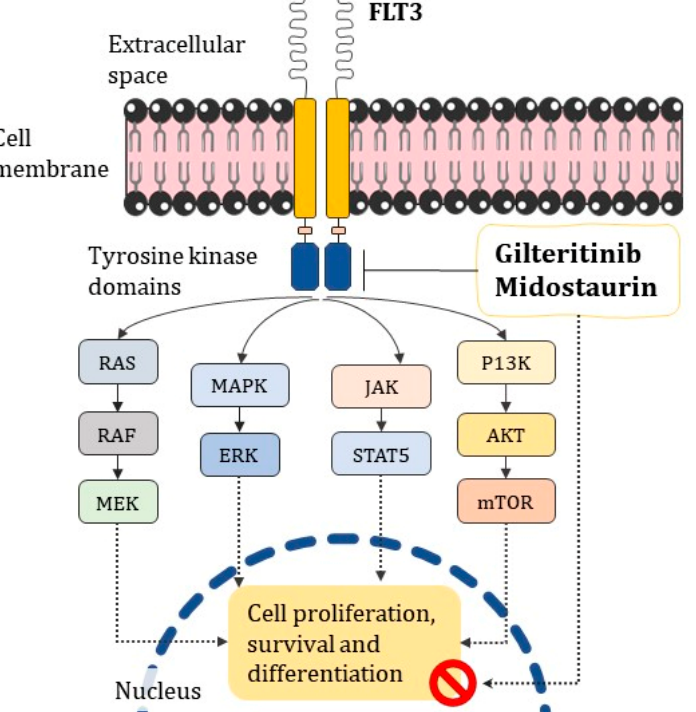
Figure 6. Gilteritinib and Midostaurin mechanism through FLT3 kinase inhibition. FLT3 mutations lead cells to proliferation, survival, and a lack of differentiation. Gilteritinib, Midostaurin, and Sorafenib are intracellular ligands to kinase receptors that block this cascade effect, returning metabolism to cell division and cell death control.